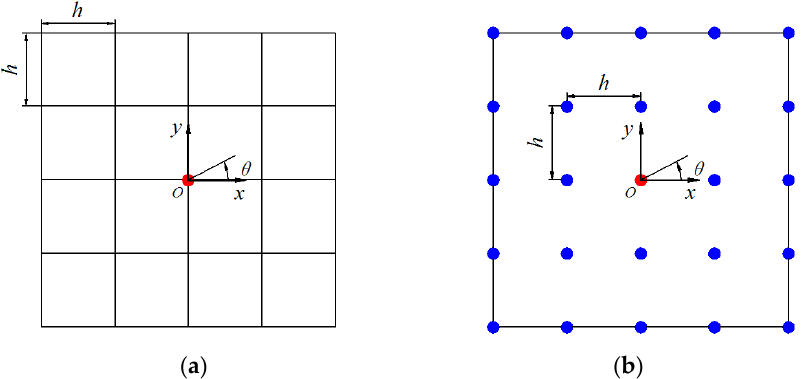
Figure 3. The evenly placed node distributions for numerical error evaluation using different nu- merical approaches: ( a ) FEM-Q4; ( b ) RPIM.